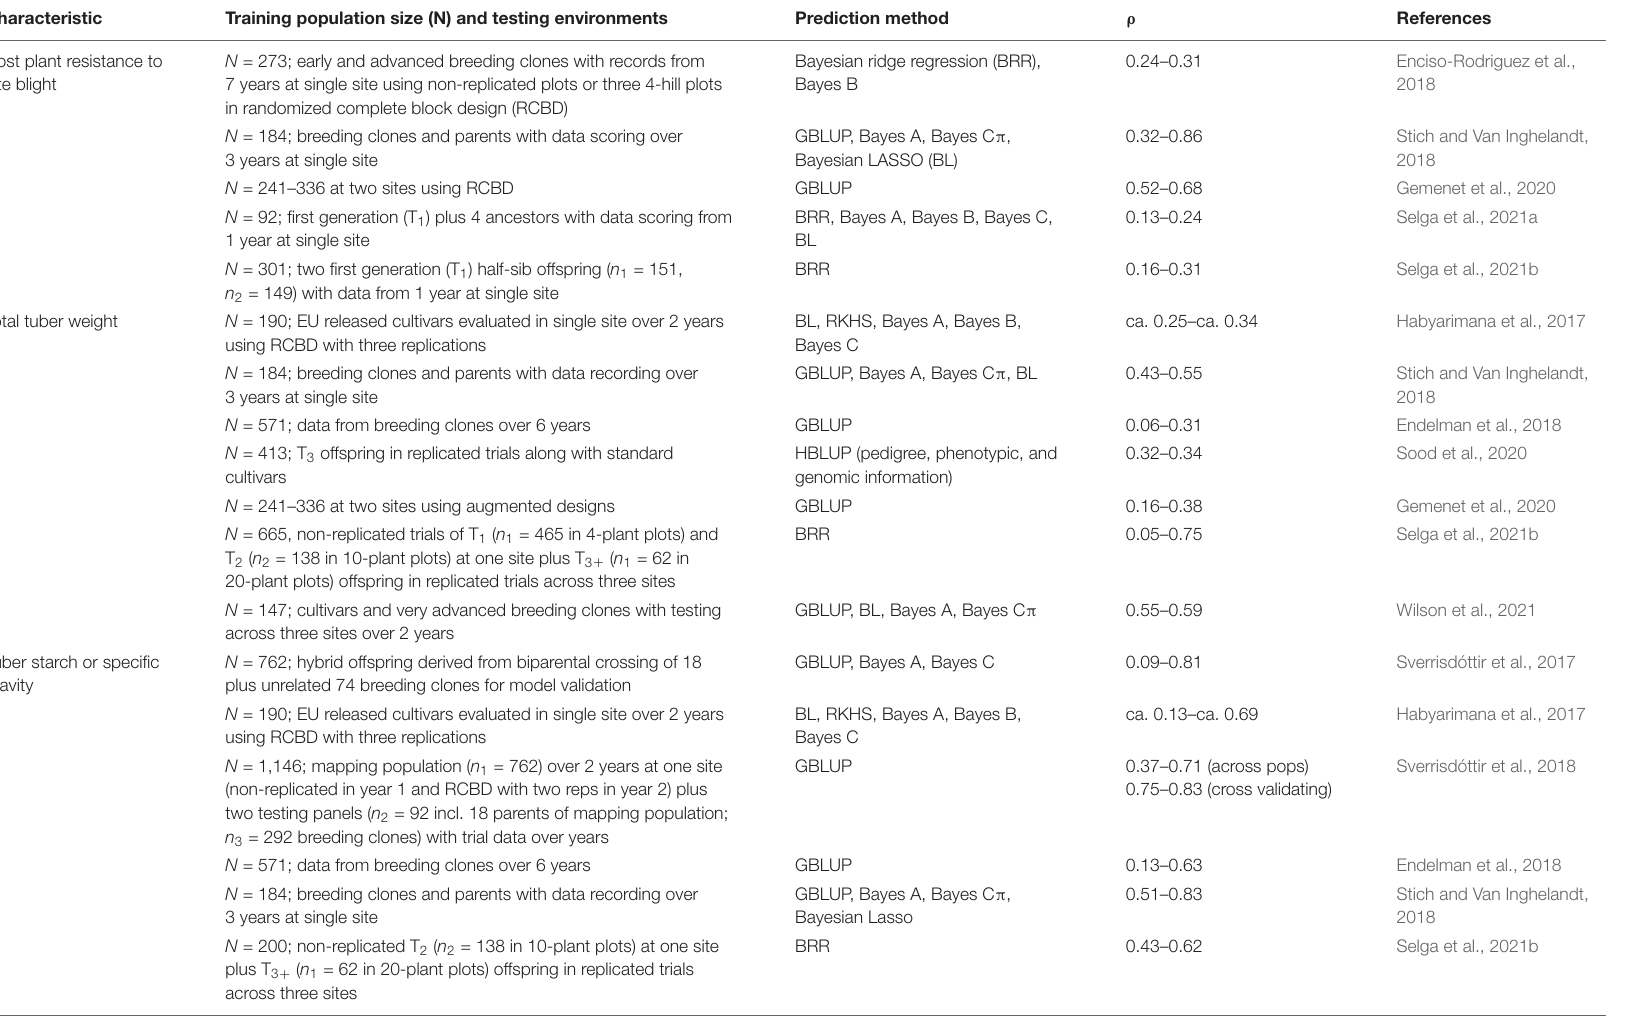
TABLE 8 | Prediction accuracy ( ρ ) ranges of breeding values for selection of host plant resistance to late blight, tuber yield, starch percentage, and crisp quality in potato using different training population sizes and varying number of testing environments.